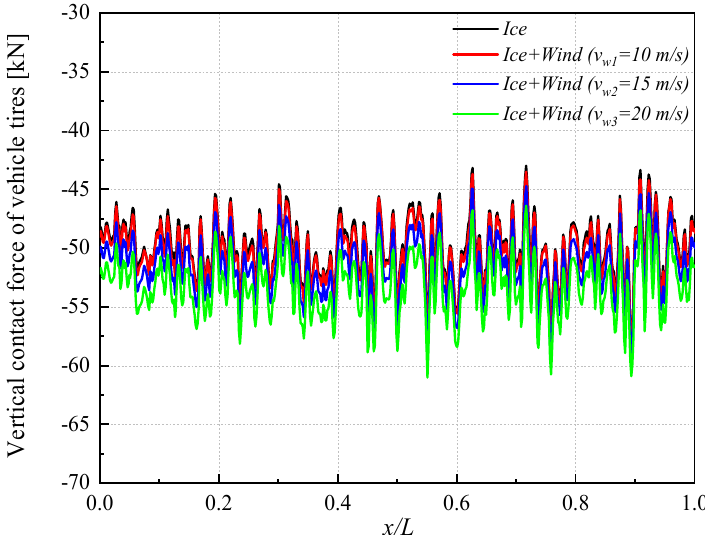
Figure 18. Vertical contact force between tires and bridge deck under combined ice and wind loads.